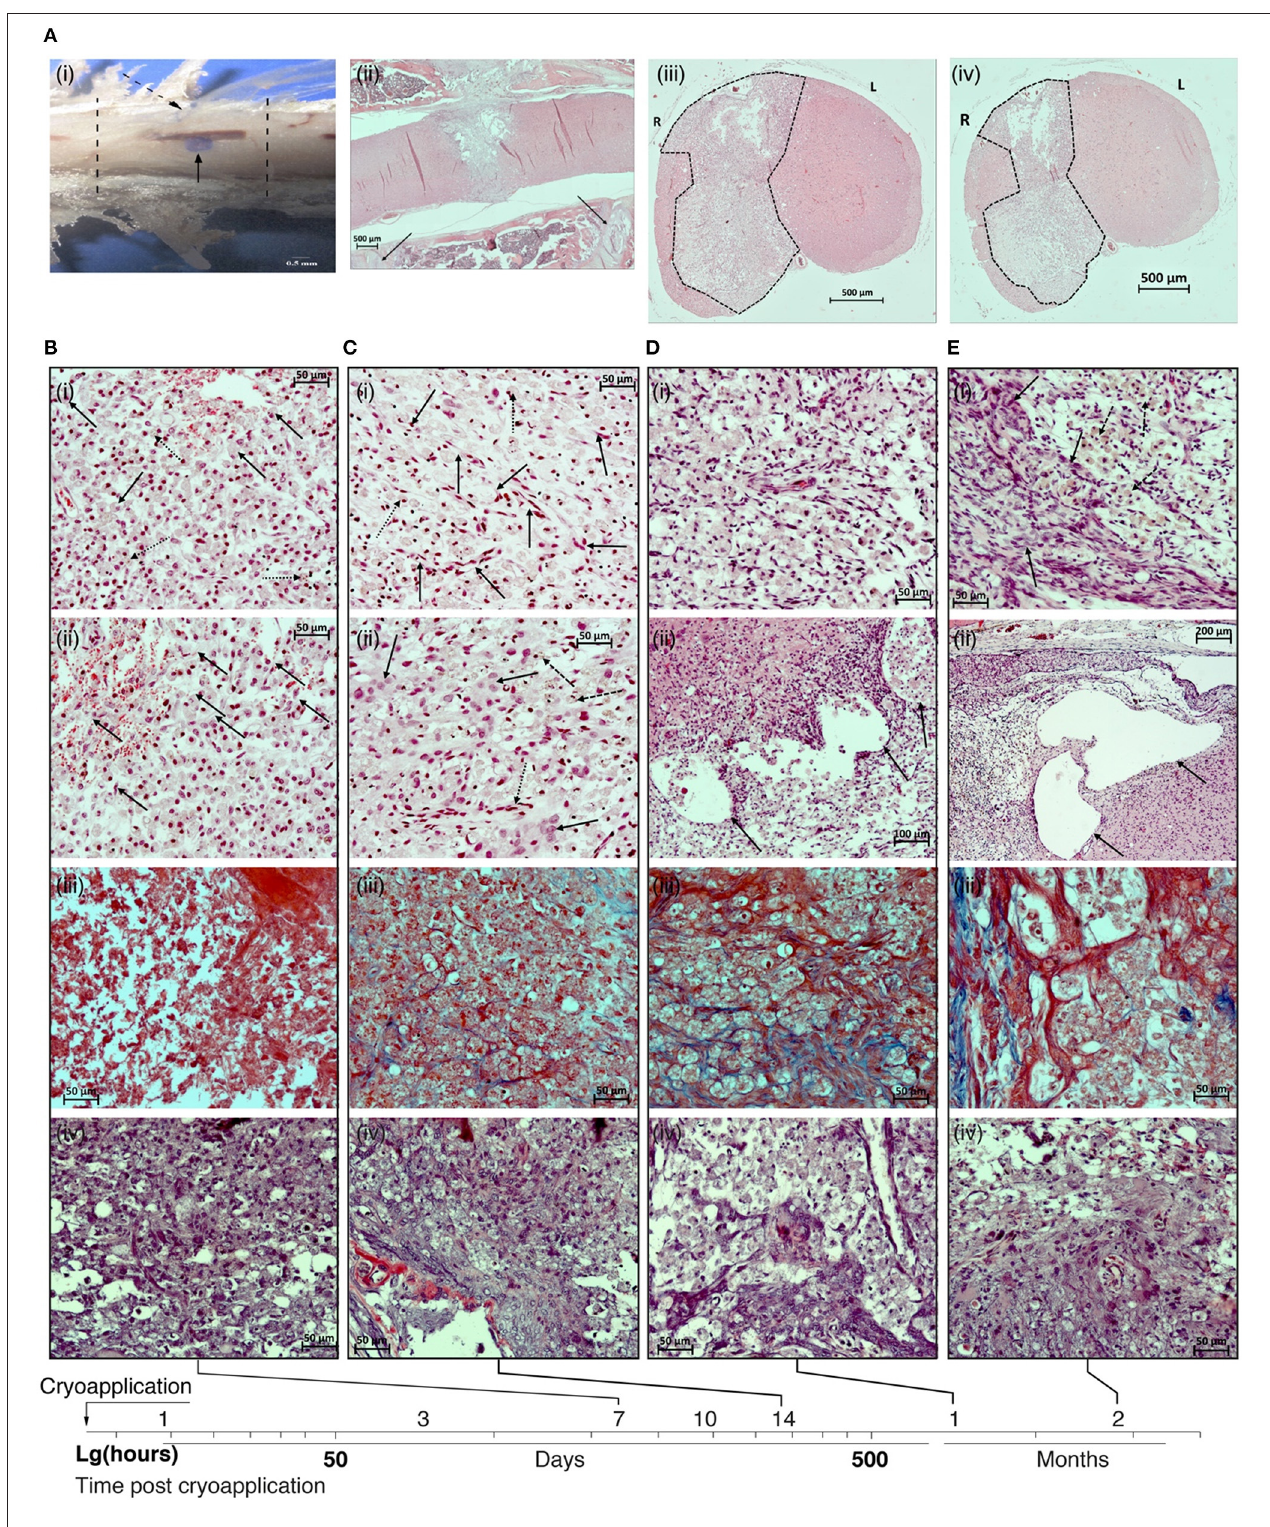
FIGURE 1 | (A) Macro- and microscopic patterns of the spinal cord lesion. (i) sample of the spinal cord together with the surrounding bone tissue. Lesion of the spinal cord (solid arrow); cryoapplication zone in the dura mater (dotted arrow); margins of Th13 vertebra (dotted lines). (ii) Panoramic image of a sagittal section of the spinal cord in the vertebral column on day 21 after the cryoinjury. The lesion is transmural, localized at the projection of the Th13 vertebra, has an ≪ hour-glass ≫ shape.